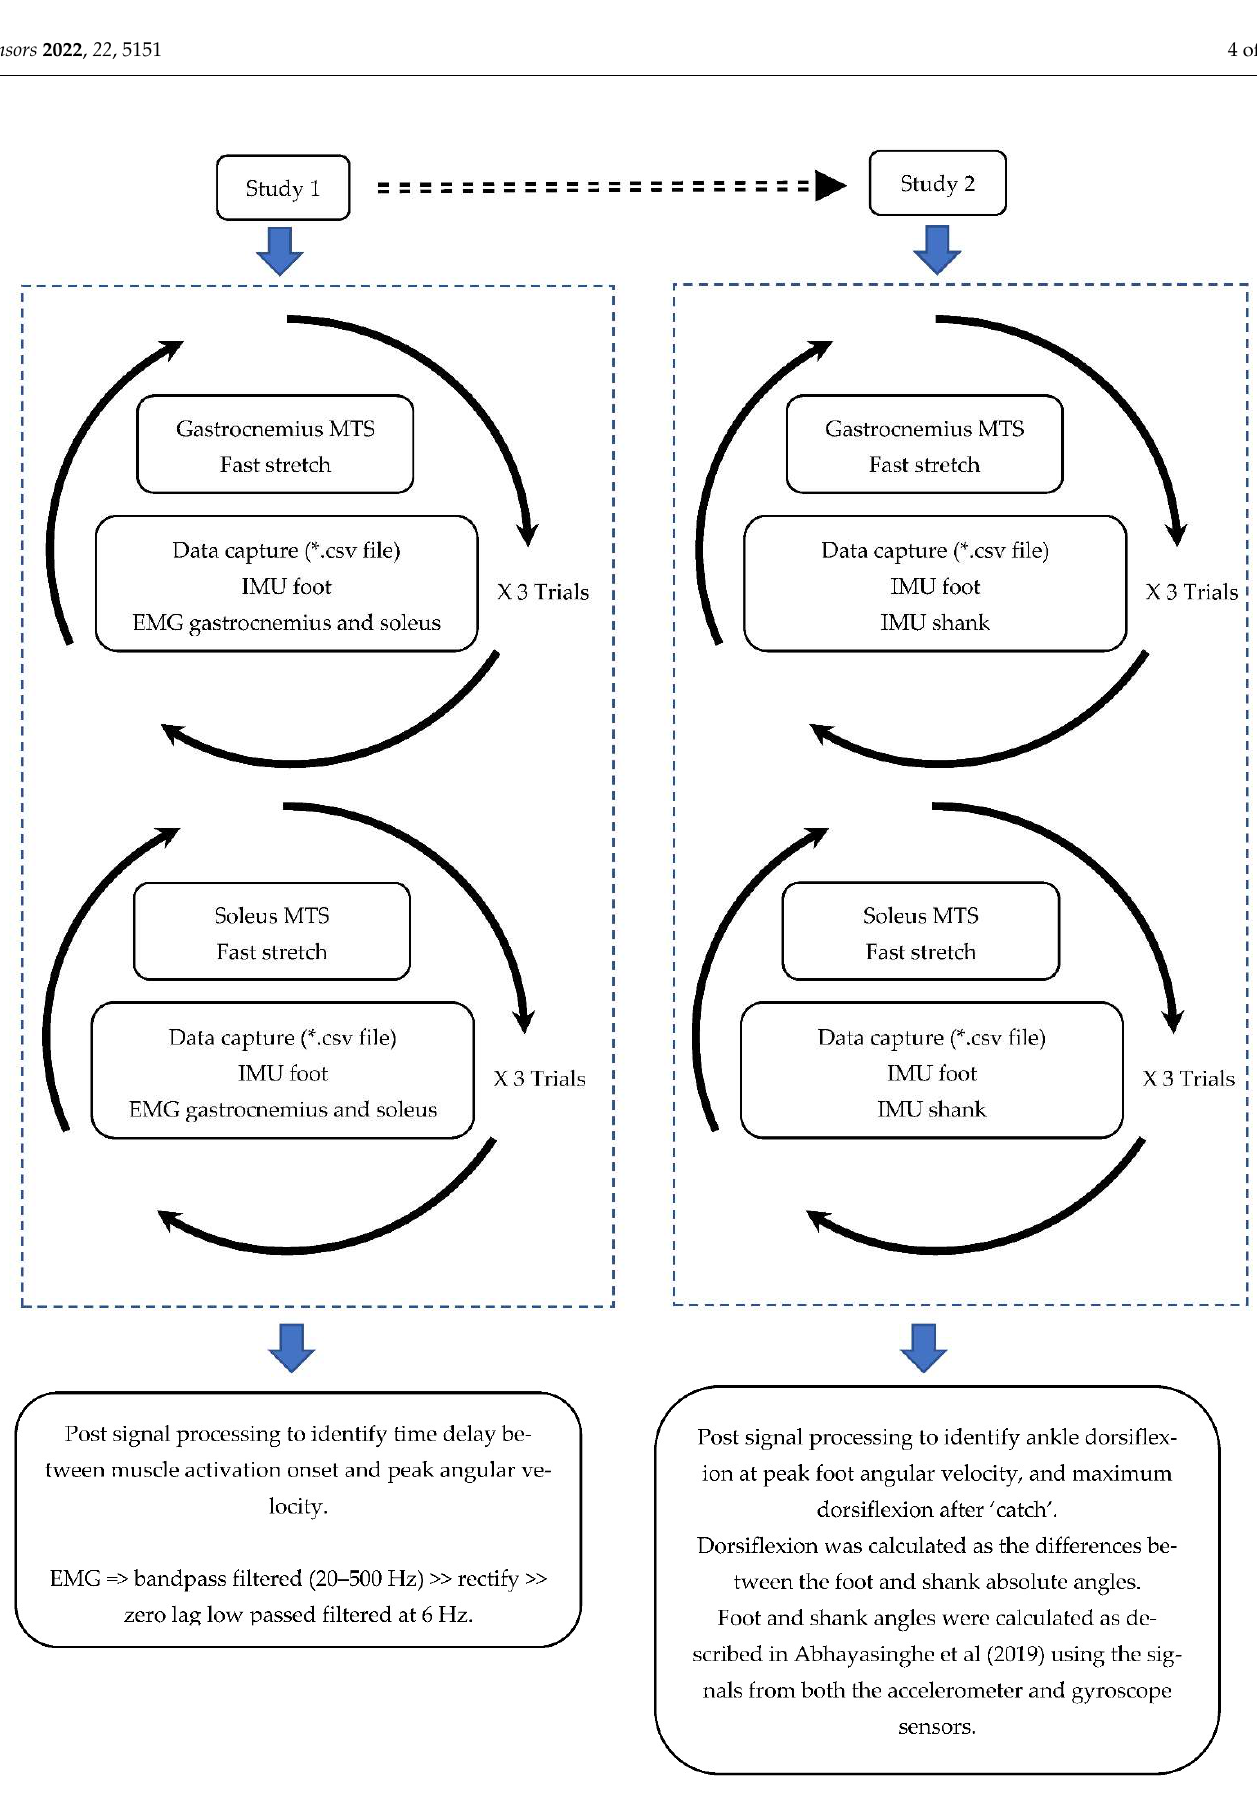
Figure 1. Schematic diagram of the MTS assessment and data processing in studies 1 and 2.